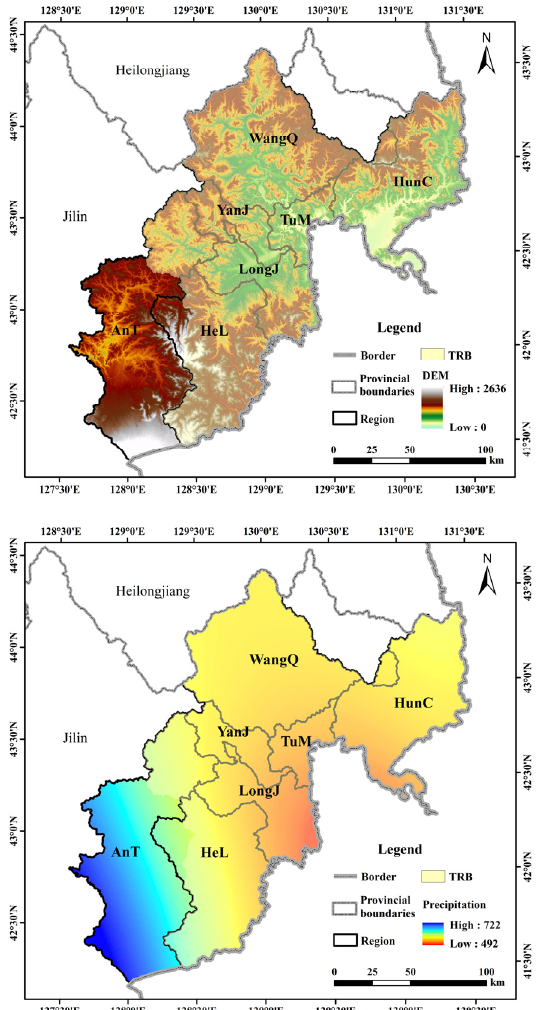
Figure 1. Geographical location and precipitation in the Tumen River Basin (TRB).